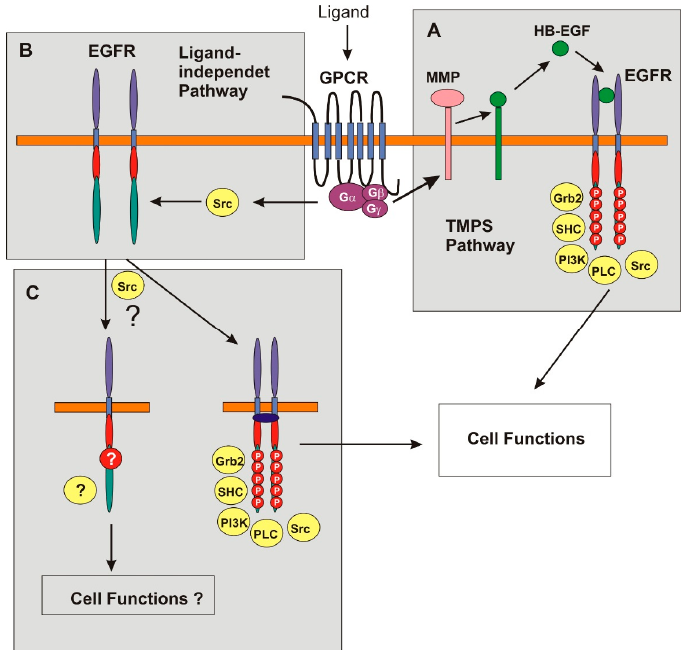
Figure 1. Schematic illustration of EGFR transactivation by GPCR. Two mechanisms have been proposed and supported by the available data: TMPS and ligand-independent intracellular